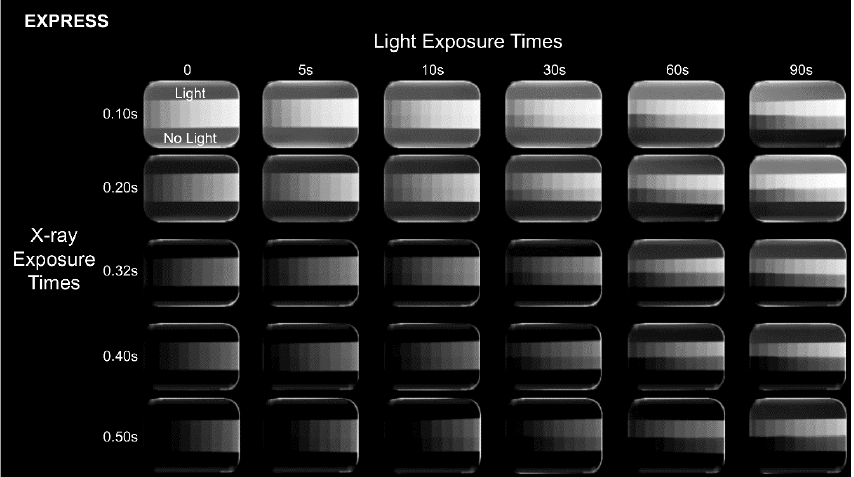
Figure 3. Representative radiographs of each experimental condition obtained using Express. All images are shown using the same display window and level.